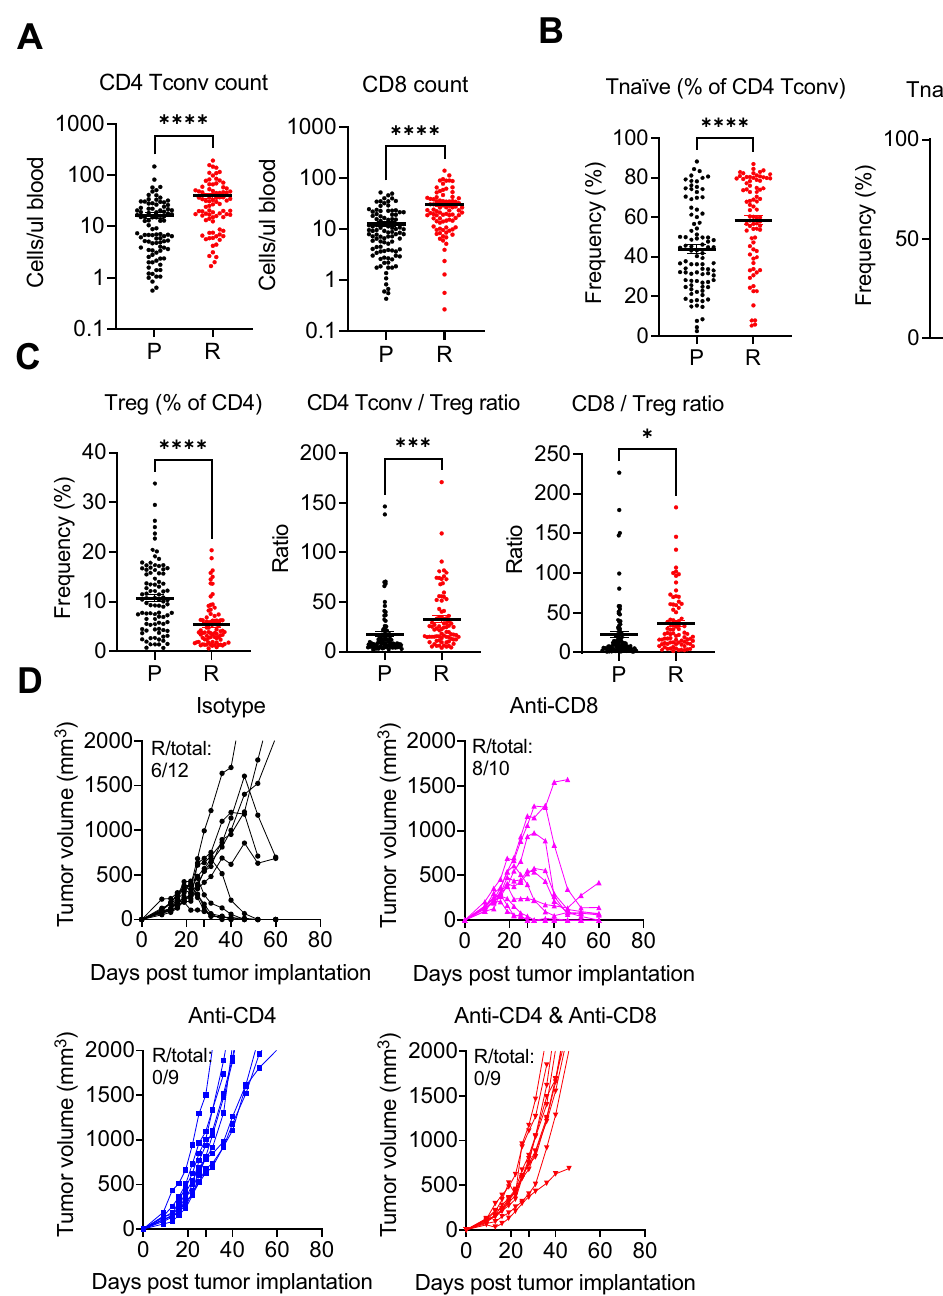
Fig. 2 CD4, but not CD8 T cells are required for tumor control. A – C Association between tumor growth outcome and T-cell phenotypes in the circulation before tumor implantation. CD4 Tconv: CD4 + FOXP3 − ; Treg: CD4 + FOXP3 + ; T naive: CD45RA + CCR7 + . Association from P ( n = 101) and R ( n = 83) are shown. The results are shown as means ± SEM. * p < 0.05, ** p < 0.01, **** p < 0.0001, unpaired t test. D Tumor growth curve of mice in the control (isotype), CD8-depleted (anti-CD8), CD4-depleted (anti-CD4), and CD4 & CD8-depleted groups (anti-CD4 & anti-CD8). The number of mice that show tumor regression or rejection out of the total number of mice of each group is shown. Antibody treatments started 9 days before tumor implantation and lasted throughout the study. Tumor growth curve is generated using repeated measurements of the same mouse over